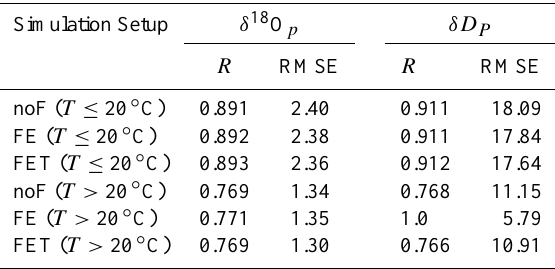
Table 1. Pearson Correlation Coefficient R and root mean square error (RMSE) of observed and by-ECHAM5-JSBACH- wiso-simulated δ 18 O p ( δD P )